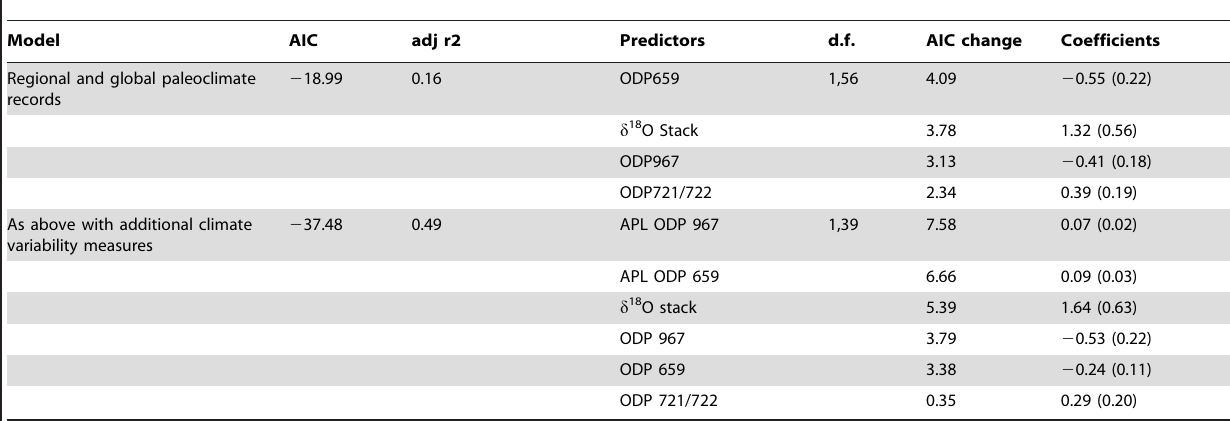
Table 1. EARS lake activity is predicted by regional paleoclimate records.